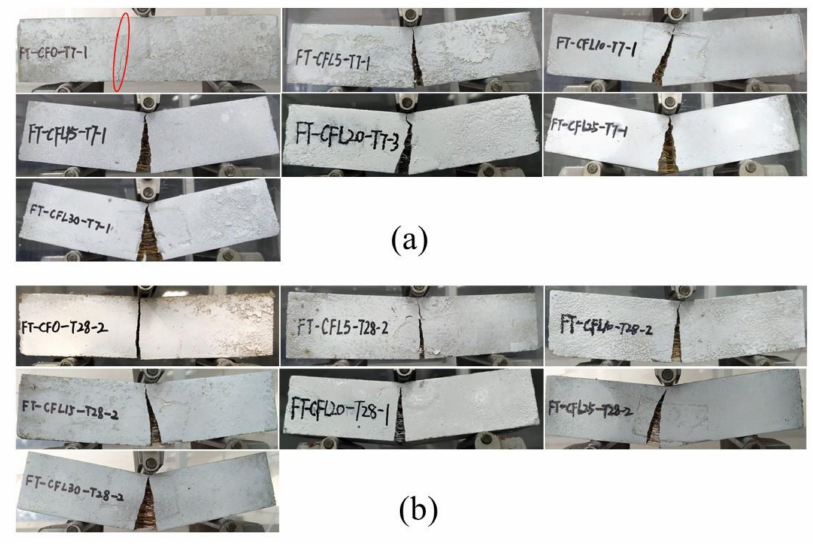
Figure 4. Failure modes: ( a ) T7; ( b )